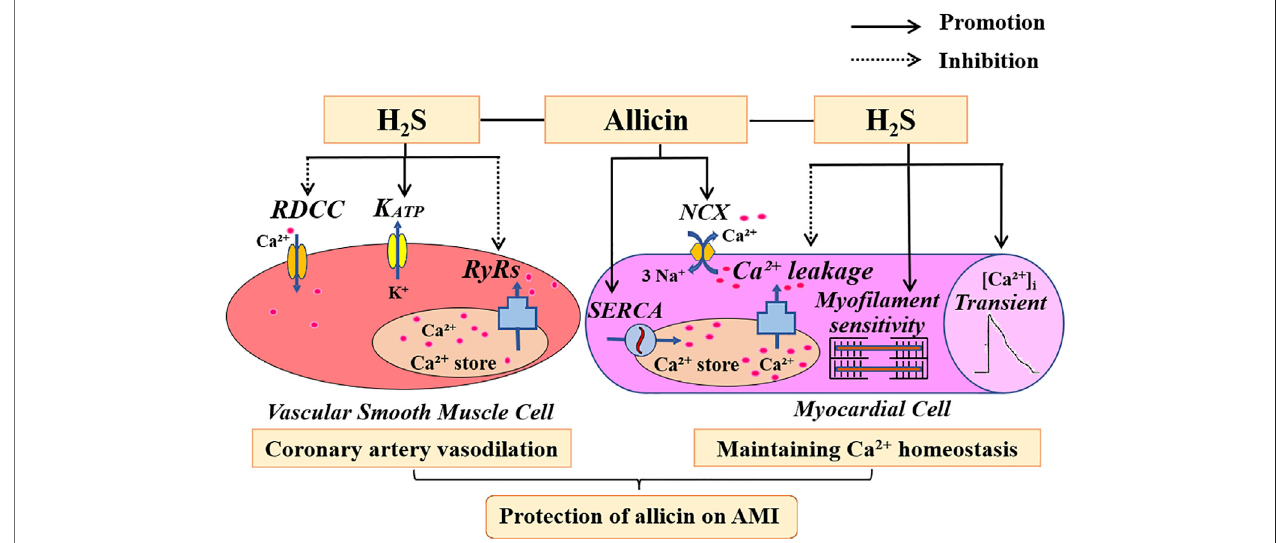
FIGURE 9 | The potential mechanism of action of allicin in an AMI rat model. Allicin administration resulted in concentration-dependent effects on coronary artery dilation, which were mediated by RDCC, K ATP , and RyRs. Allicin administration improved Ca 2+ homeostasis in the cardiomyocytes of rats with AMI by increasing cardiomyocyte contraction, Ca 2+ transient amplitude, myo fi lament sensitivity, and SR Ca 2+ content. Allicin also enhanced the Ca 2+ uptake induced by SERCA and the Ca 2+ removal induced by the NCX, and reduced Ca 2+ leakage. H 2 S is partially involved in the anti-AMI effects of allicin. Abbreviations: RDCC, receptor-dependent Ca 2+ channels; K ATP , ATP-sensitive potassium channels; RyRs, ryanodine receptors; SERCA, sarco/endoplasmic reticulum Ca 2+ -ATPase; NCX, Na + /Ca 2+ exchanger; AMI, acute myocardial